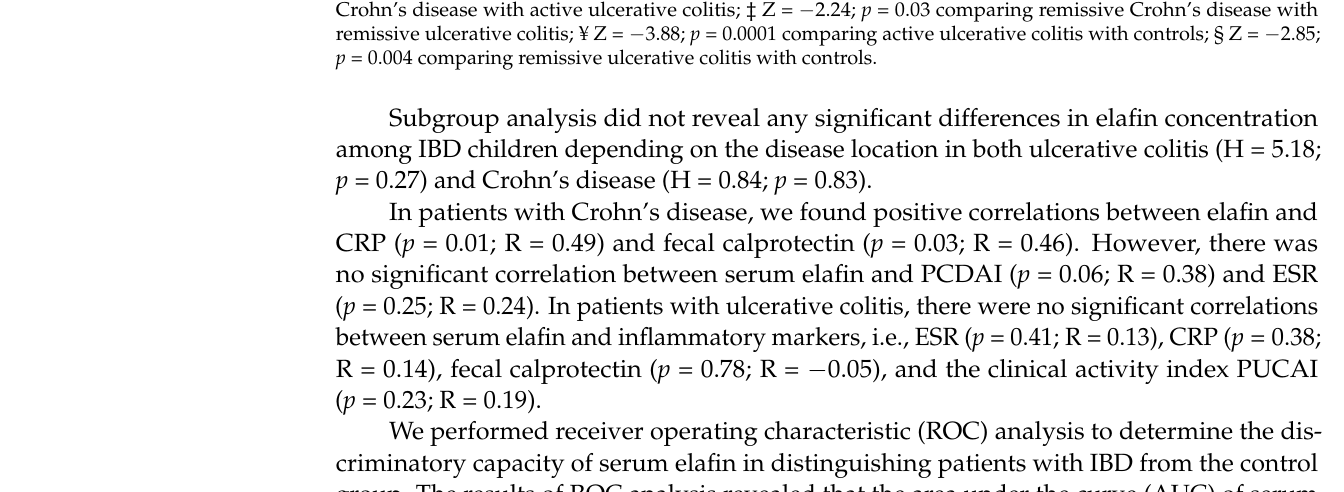
Table 1. Comparison of serum elafin in IBD patients in terms of disease activity to the control group.